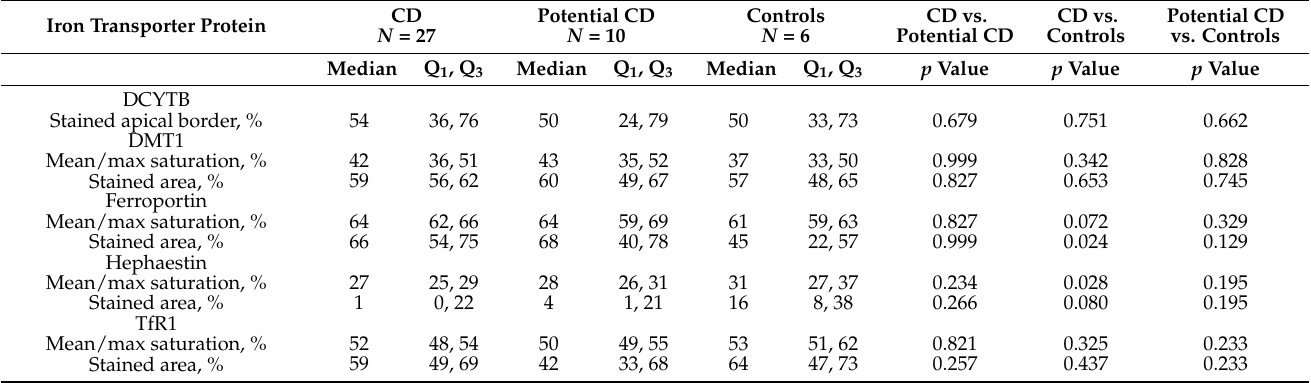
Table 2. Iron transporter protein saturations and the stained areas of enterocytes in the duodenal biopsies of the study